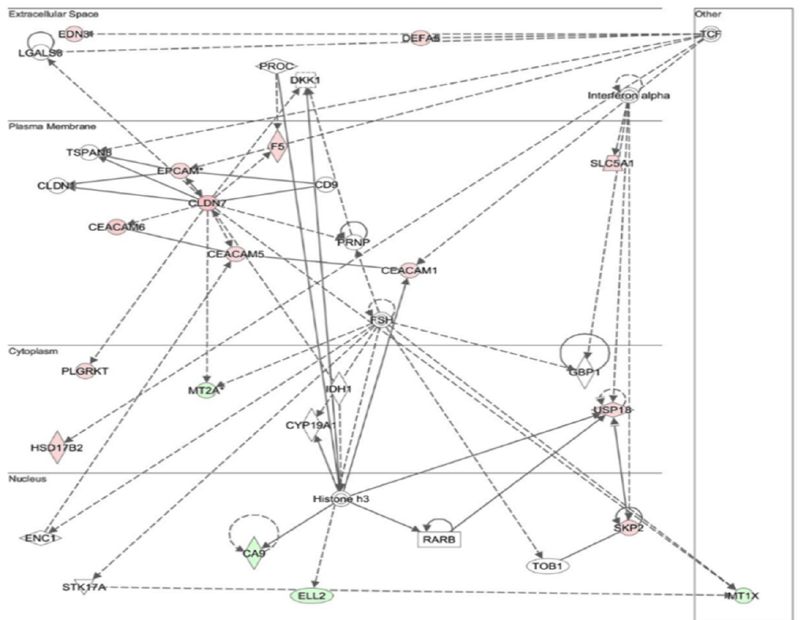
Figure 2. Network of functional cell movement, tissue growth, and development and function of the digestive system related to chronic atrophic gastritis vs. control group. Colors: red, gene overexpression; green, gene subexpression. The intensity of the color indicates the degree of over- or subexpression. Encoding form: rectangle—nuclear receptor ligand-dependent; oval—transcription regulator; rhombus—enzyme; circle—other. Table 3. Enriched gene ontology categories of the transcripts in gastric cancer compared to the control group.